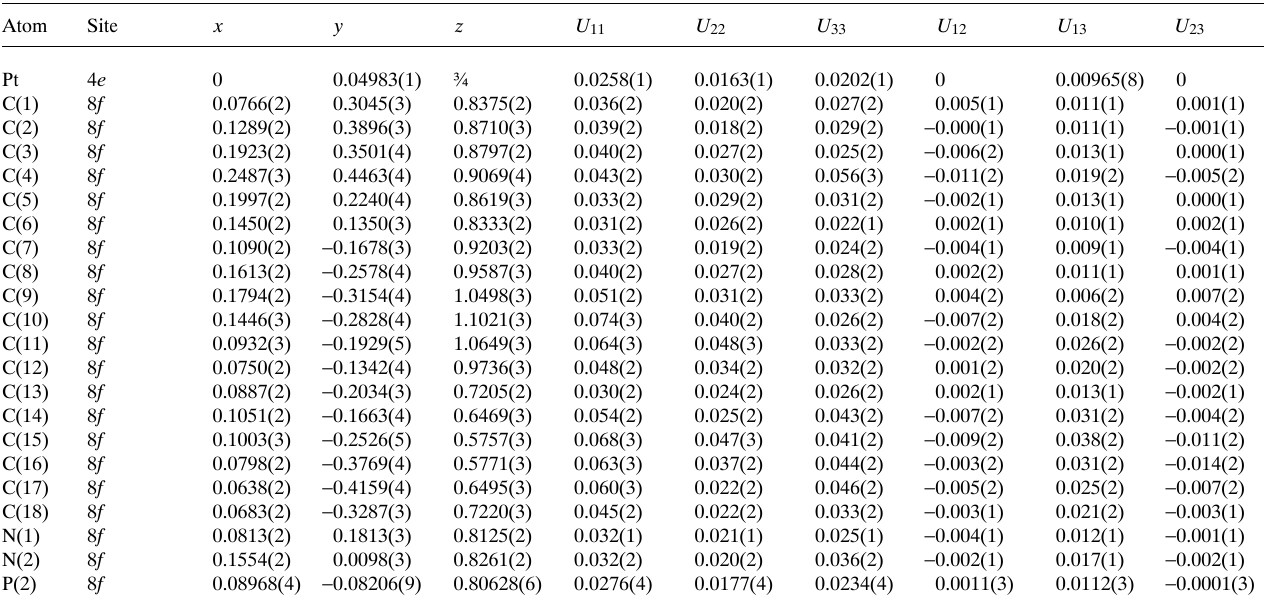
Table 3. A tomic coordin a tes a nd displ a cement p a r a meters (in Å 2 )